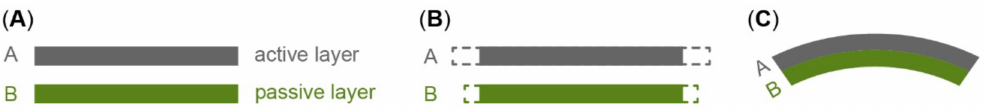
Figure 7. ( A ) Bimetal consists of two layers of metal with different rates of thermal expansion; ( B ) these metals, when heated, expand differently; ( C ) such layers are permanently linked to each other. As the passive layer limits the active layer, the bimetal compound follows a deflection curve when heated. Source: adapted from